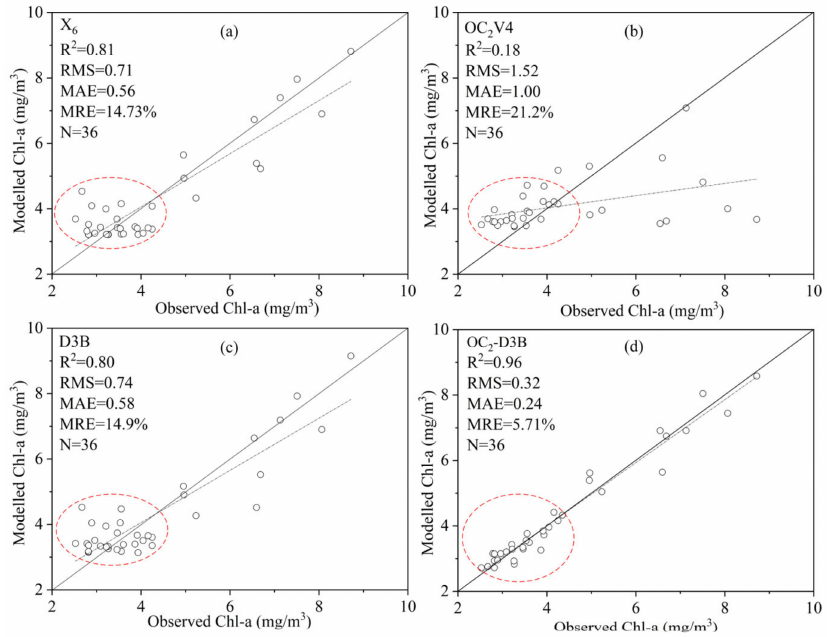
Figure 12. In situ chl-a versus estimated chl-a of X 6 ( a ), OC2V4 ( b ), D3B ( c ) and OC2-D3B ( d ) for all the